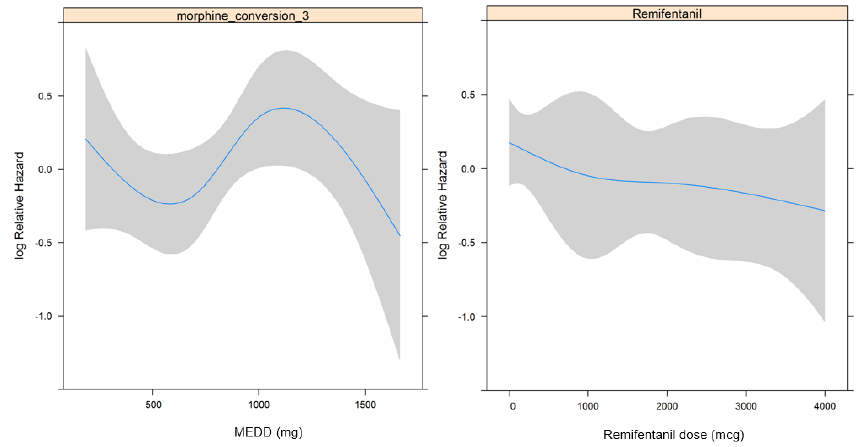
Figure 2. Restricted cubic spline in relation to opioid dosage ( a ) and remifentanil dosage ( b ) with overall survival.